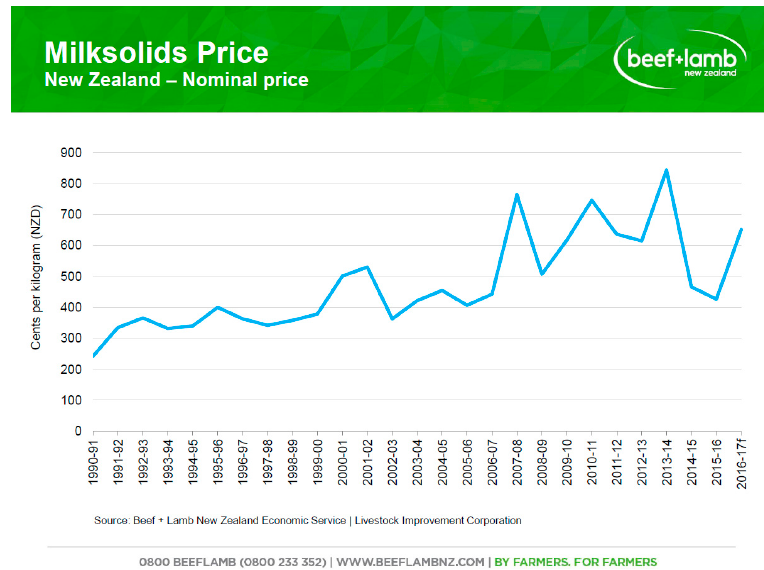
Figure 2. A 10-year movement in milksolids prices in New Zealand is shown [3].